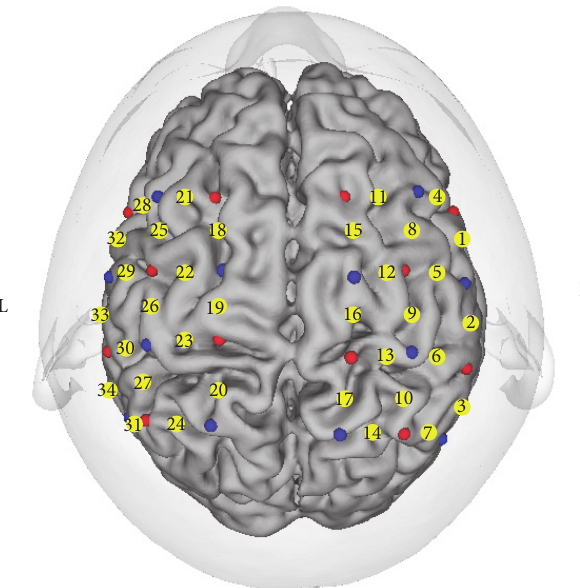
Figure 5: Projection of the probes and the channels onto the brain surface, using MRI data and a 3D position detector. Red: source, blue: detector, and yellow: